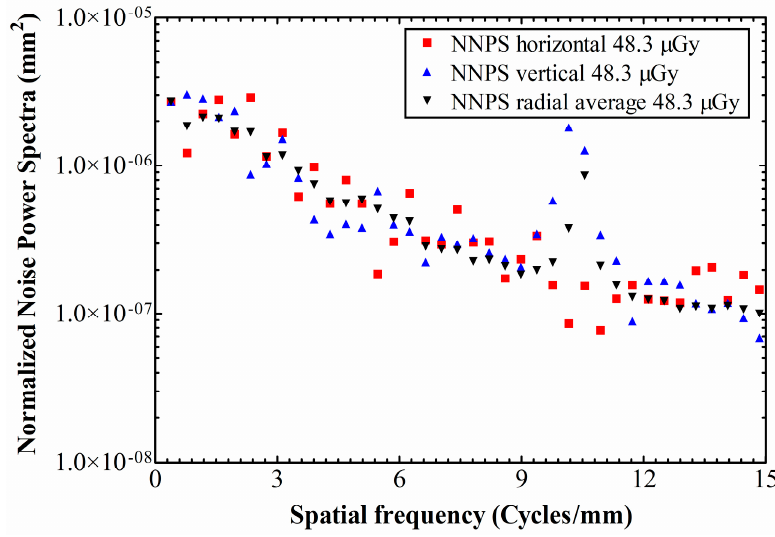
Figure 6. NNPS values at an exposure level of 48.3 µ Gy.